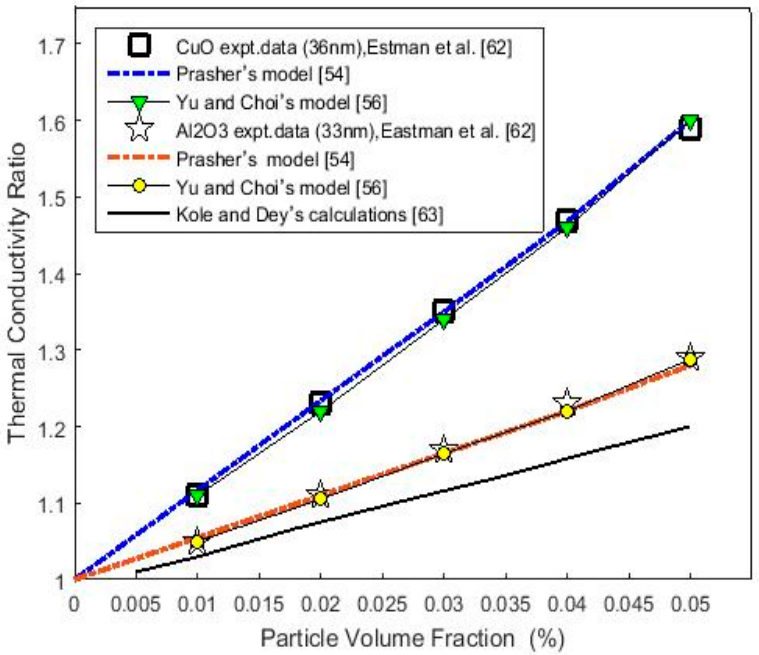
Figure 1. (Color online) Calculated thermal conductivity ratio (K ceff /K m ) versus the particle volume fraction for Al 2 O 3 and CuO nanoparticles in a water base fluid using the Prasher’s model (Equation (1)) and Yu and Choi’s model (Equation (6)). Expt. data are from [62]. The solid black-line is from Kole and Dey’s calculations [63].